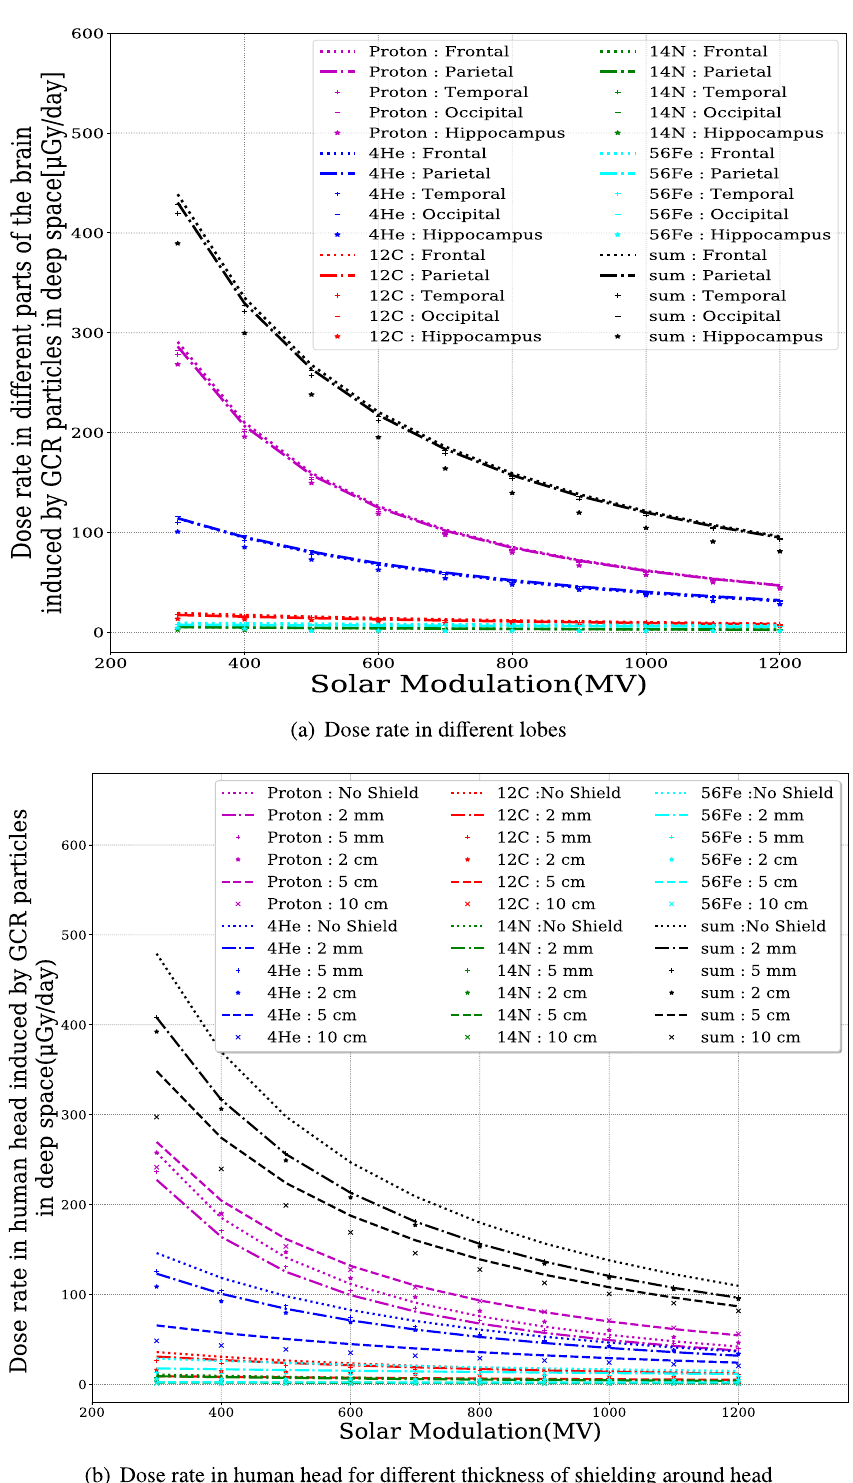
Figure 3. ( a ) The dose rates in different parts of the brain induced by GCR particles in deep space without shielding protection. ( b ) The dose rates in the human head under different thickness of shielding. The primary source GCRs include protons, helium and heavier ions such as carbon, nitrogen and iron under different solar modulation conditions. The summed dose rates from all these primary particles under different conditions (i.e., solar modulations, shielding depth and different lobes) are shown in